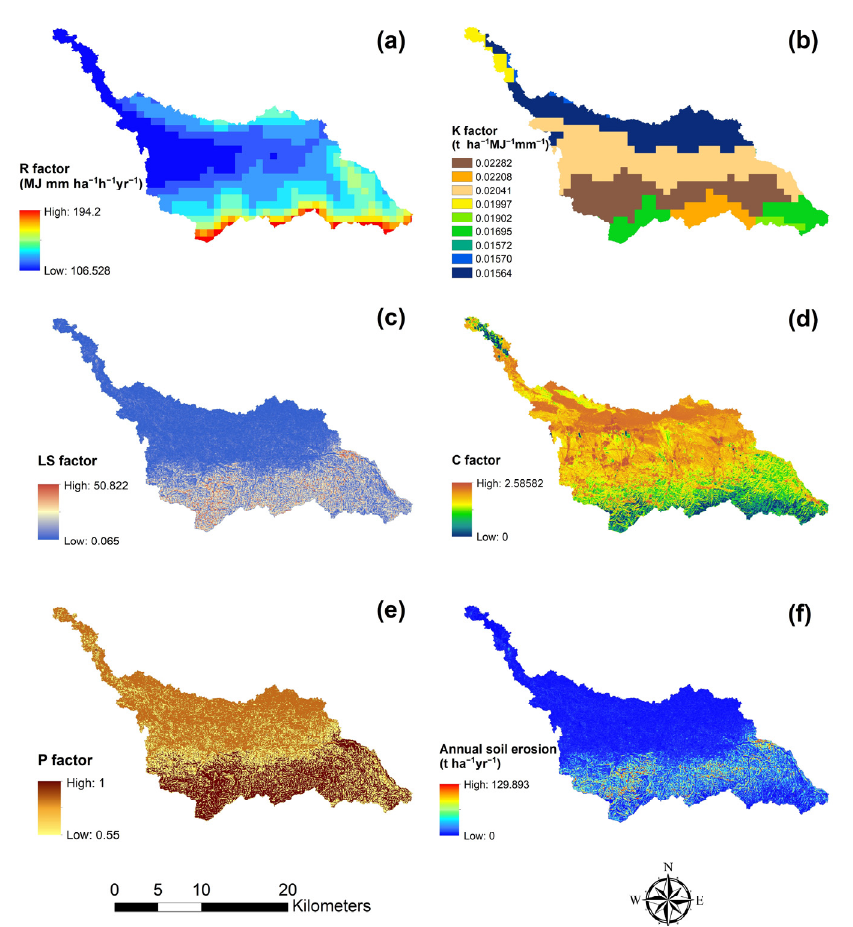
Figure 3. Parameters of calculated RUSLE, and the annual soil erosion of HTYZ area. Specifically, ( a ) R factor, ( b ) K factor, ( c ) LS factor, ( d ) C factor, ( e ) P factor, and ( f ) soil annual loss of HTYZ area, respectively.